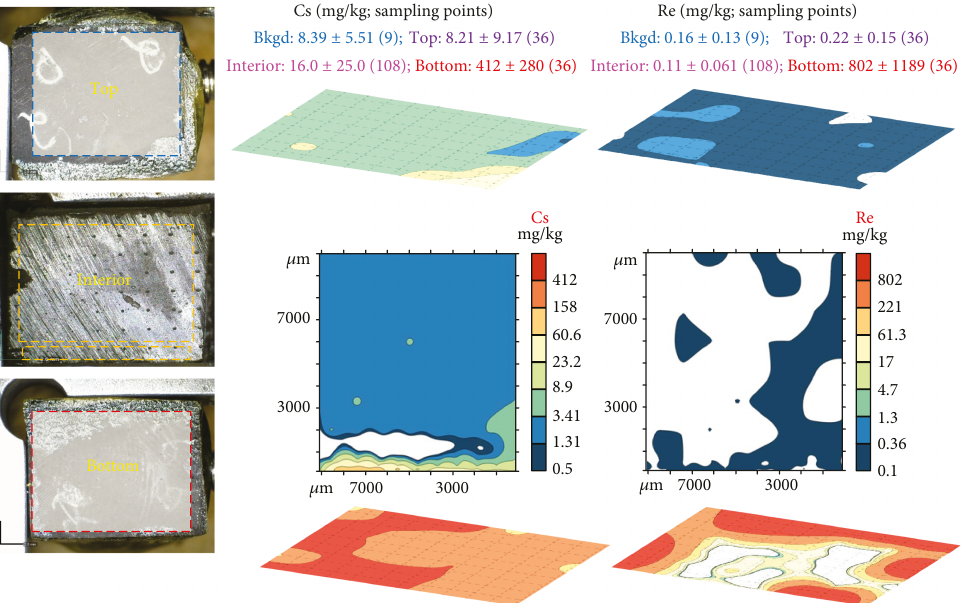
− tracers in API brine into B-13010 sample of Springer shale, mapped on three faces (top, interior, and Figure 8: Imbibition of Cs + and ReO 4 bottom; from top to bottom for each vertical panel of photos and tracer results, each tick on the x - and y -axes has a scale of 1000 μ m); imbibition time is 24.3 hrs. The laser spot size for sampling is 100 μ m, while the interior grid sizes cover the whole sample and are mapped with a two-grid scheme of variable spacing between spots to catch the concentration change near the bottom edge, as shown in the interior photo on which the laser spots are visible. The bottom photo shows the custom-made aluminum chuck, with two screws (tip shown in the top photo, to the right) to place the sample during the tracer mapping. The white areas indicate the regions of tracer concentration below the detection limit of LA-ICP-MS approach.